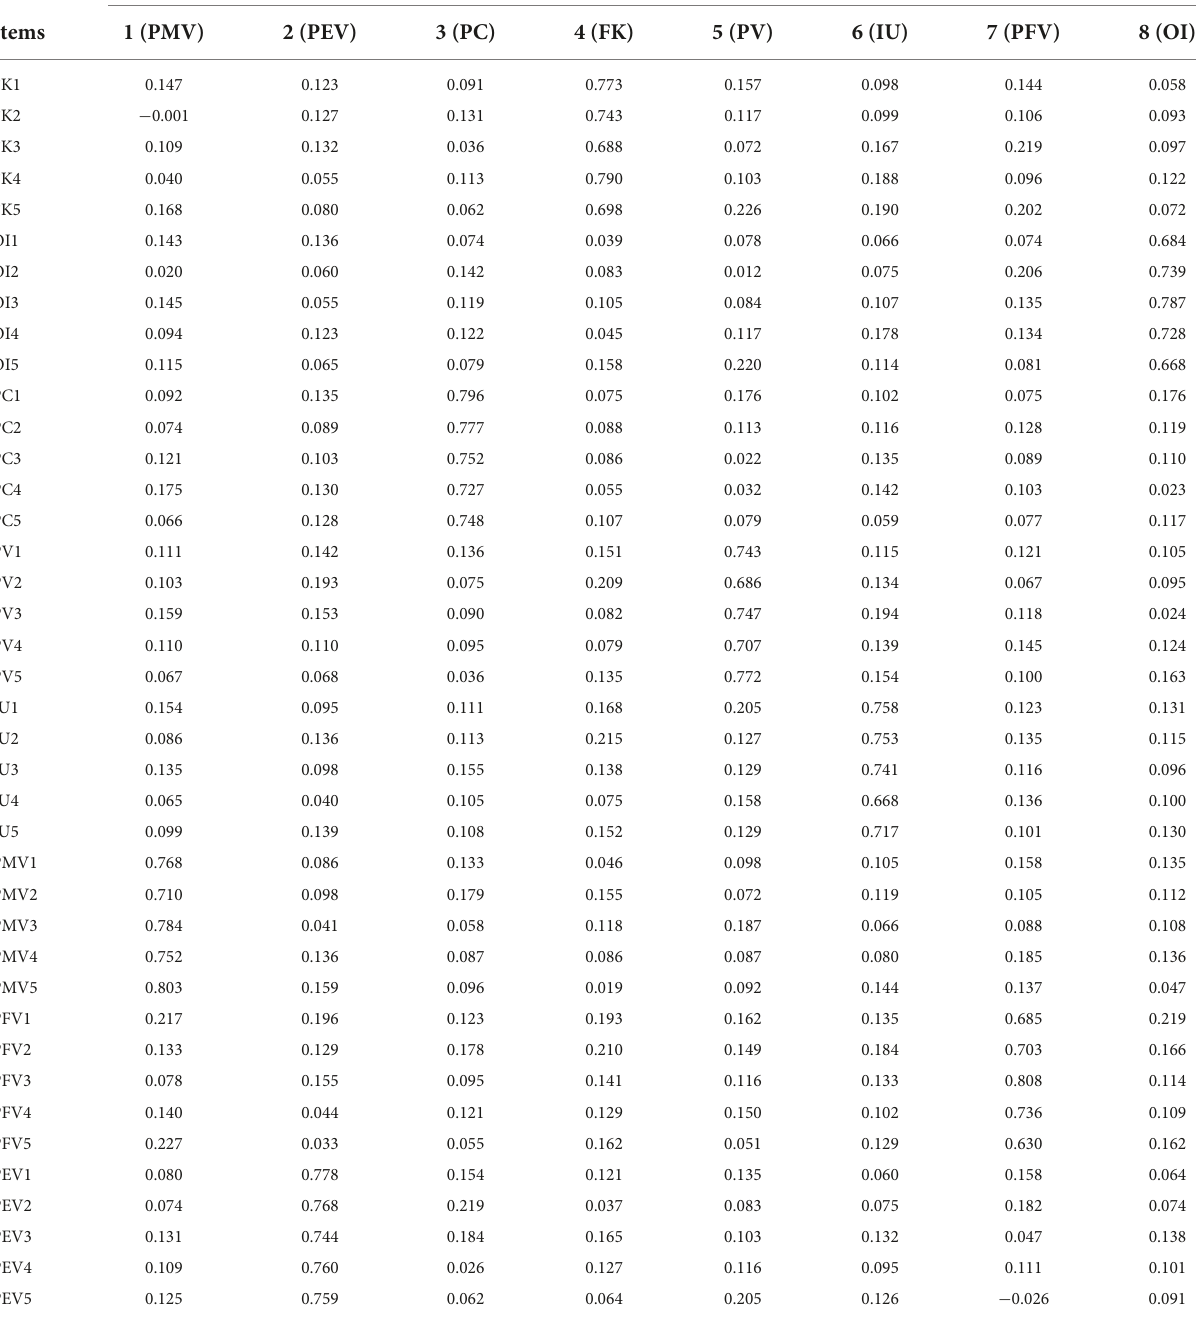
TABLE 2B Results of the exploratory factor analysis (component